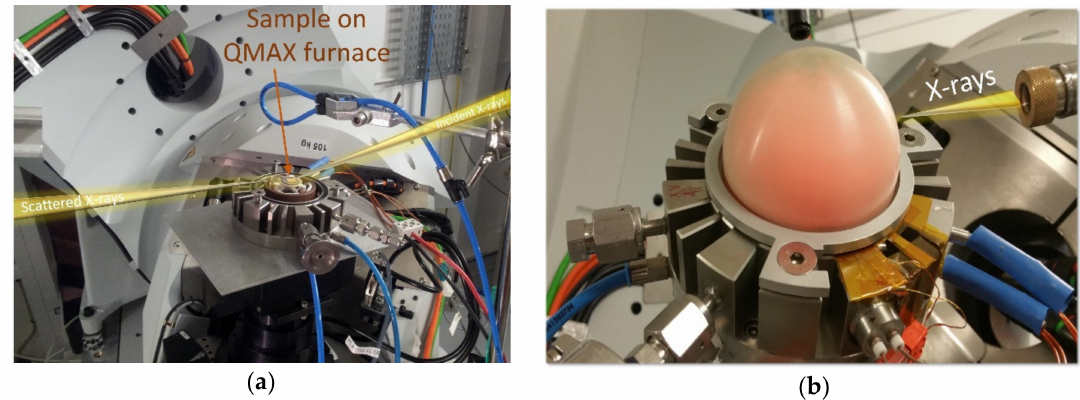
Figure 5. The QMAX heating stage with a sample fixed on a ceramic plate heated ( a ) in air and ( b ) under a PEEK (PolyEther Ether Ketone) dome.